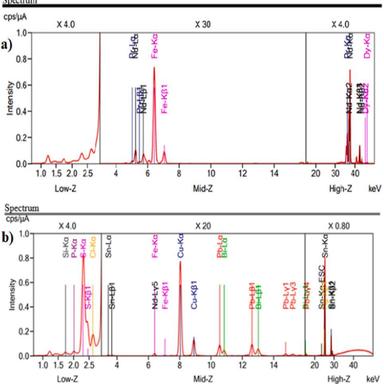
a) XRF spectrum results for the magnet specimen removed from the e-waste. b) XRD Spectrum results for the solder joint samples extracted from PCB.